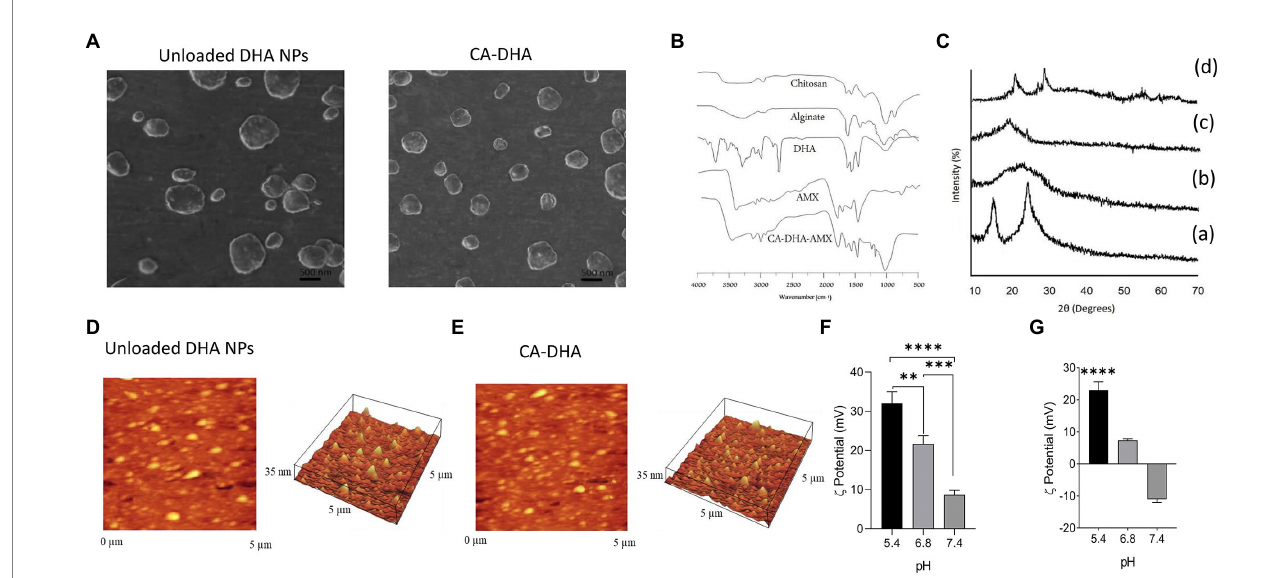
FIGURE 1 Physicochemical properties of CA-based NPs. (A) SEM micrograph of CA NPs and CA-DHA-AMX NPs (CA = 1%, DHA = 100 μ M, 2% v/v, and AMX = 60 mg/ml). (B) FTIR spectra of chitosan, alginate, DHA (100 μ M), AMX, and CA-DHA-AMX NP. (C) XRD patterns of chitosan (a), alginate (b), DHA (c), and CA-DHA (d). (D,E) AFM analysis of the surface topography of the unloaded and DHA-loaded NPs. (F,G) Zeta potentials of unloaded and DHA-loaded NPs (2% v/v) at various pH